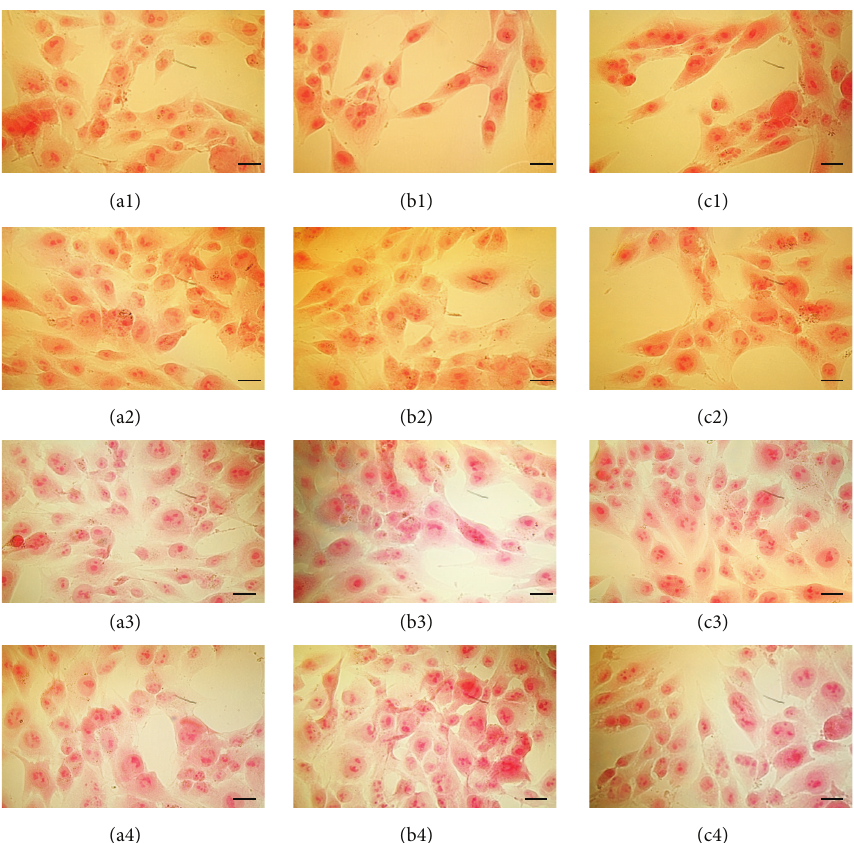
Figure 3: Pictures were taken under optical microscopy of the cells treated for 24h with different NSAIDs ((1) dexketorpofen; (2) ketorolac; (3) metamizole; (4) acetylsalicylic acid) at different doses ((a) control; (b) 1 𝜇 M; (c) 10 𝜇 M) in nonosteogenic medium and dyed with Sirius red for to see the synthesis of collagen fibrins. Bars = 50 𝜇